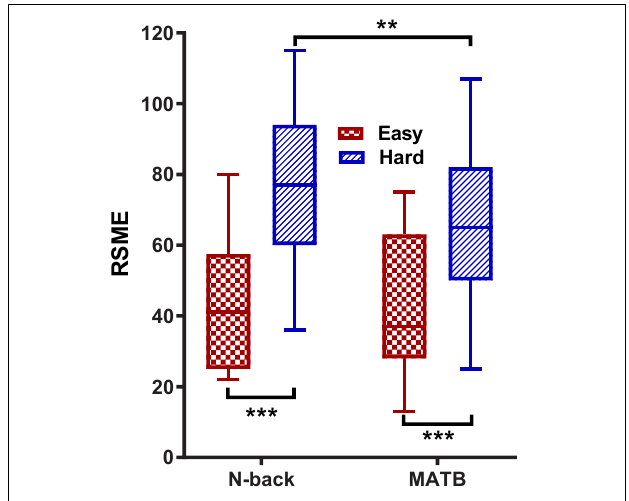
FIGURE 1 | Box plots of Mental Effort Rating Scale for easy and hard conditions in both tasks. The asterisks indicate the significance levels: ** p < 0.01; *** p <